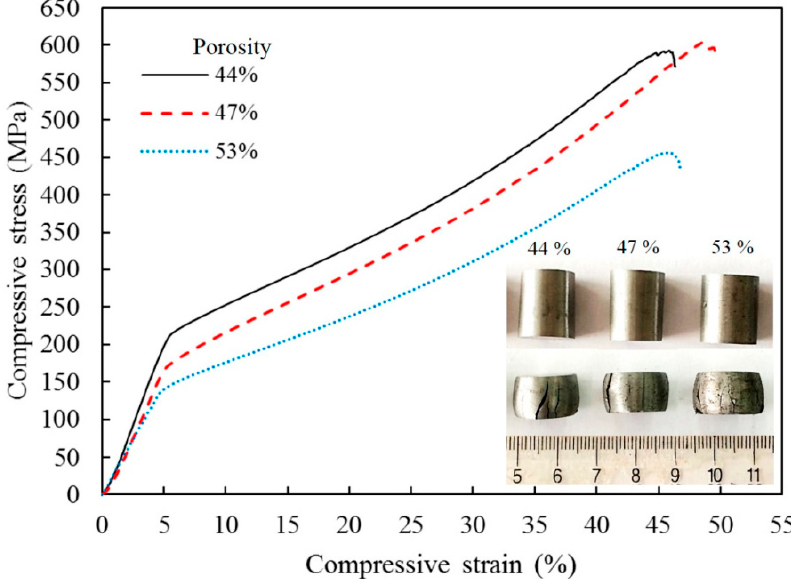
Figure 17. Room temperature uniaxial compressive stress–strain curves of porous iron prepared by pressureless SPS from the pre-compacted iron nitride powder. Reprinted from Cui et al. [40],